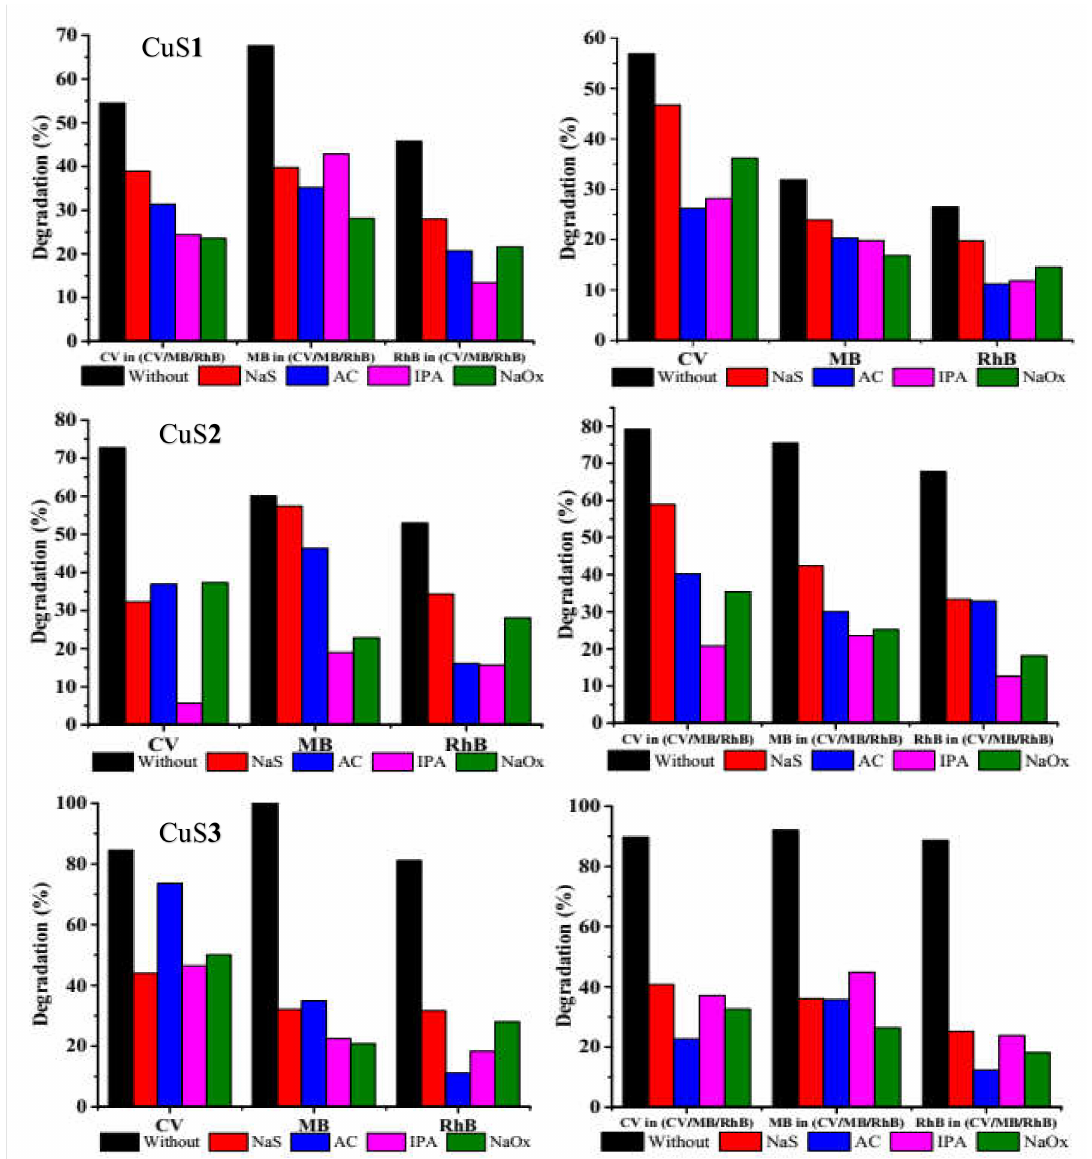
Figure 8. Effects of scavengers on single and ternary dyes over CuS